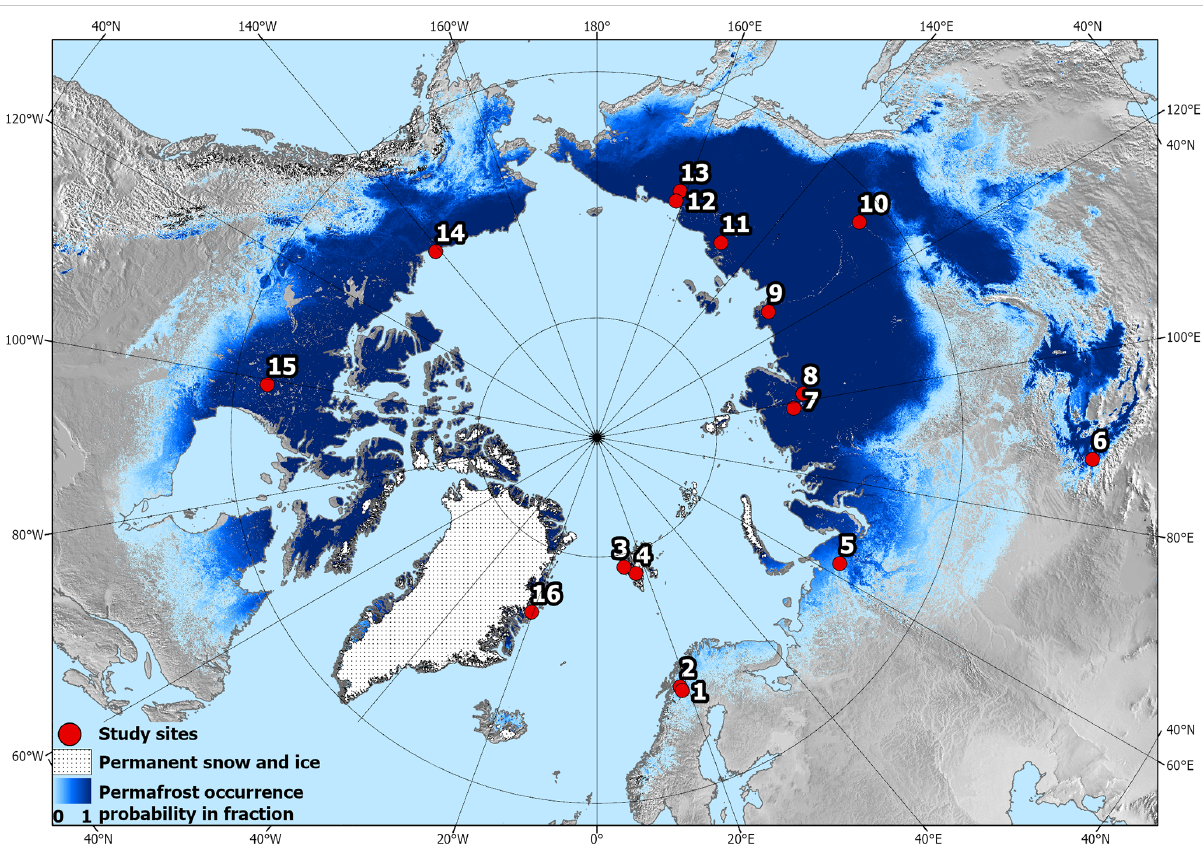
Figure 1. Overview map with location of the 16 sampling sites (see Table 1). Blue shading indicates permafrost probability (dark hues showing higher permafrost occurrence probability), based on an equilibrium state model for the temperature at the top of the permafrost (TTOP) for the 2000–2016 period (Obu et al., 2019). North Pole Lambert azimuthal equal area projection (datum: WGS 84). Base map: made with Natural